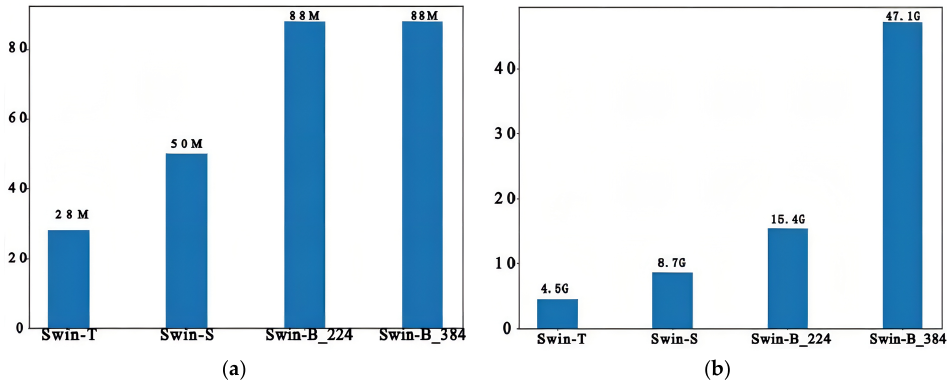
Figure 7. Comparison of params and flops in classification mission. ( a ) Comparison of params; ( b ) Comparison of flops.